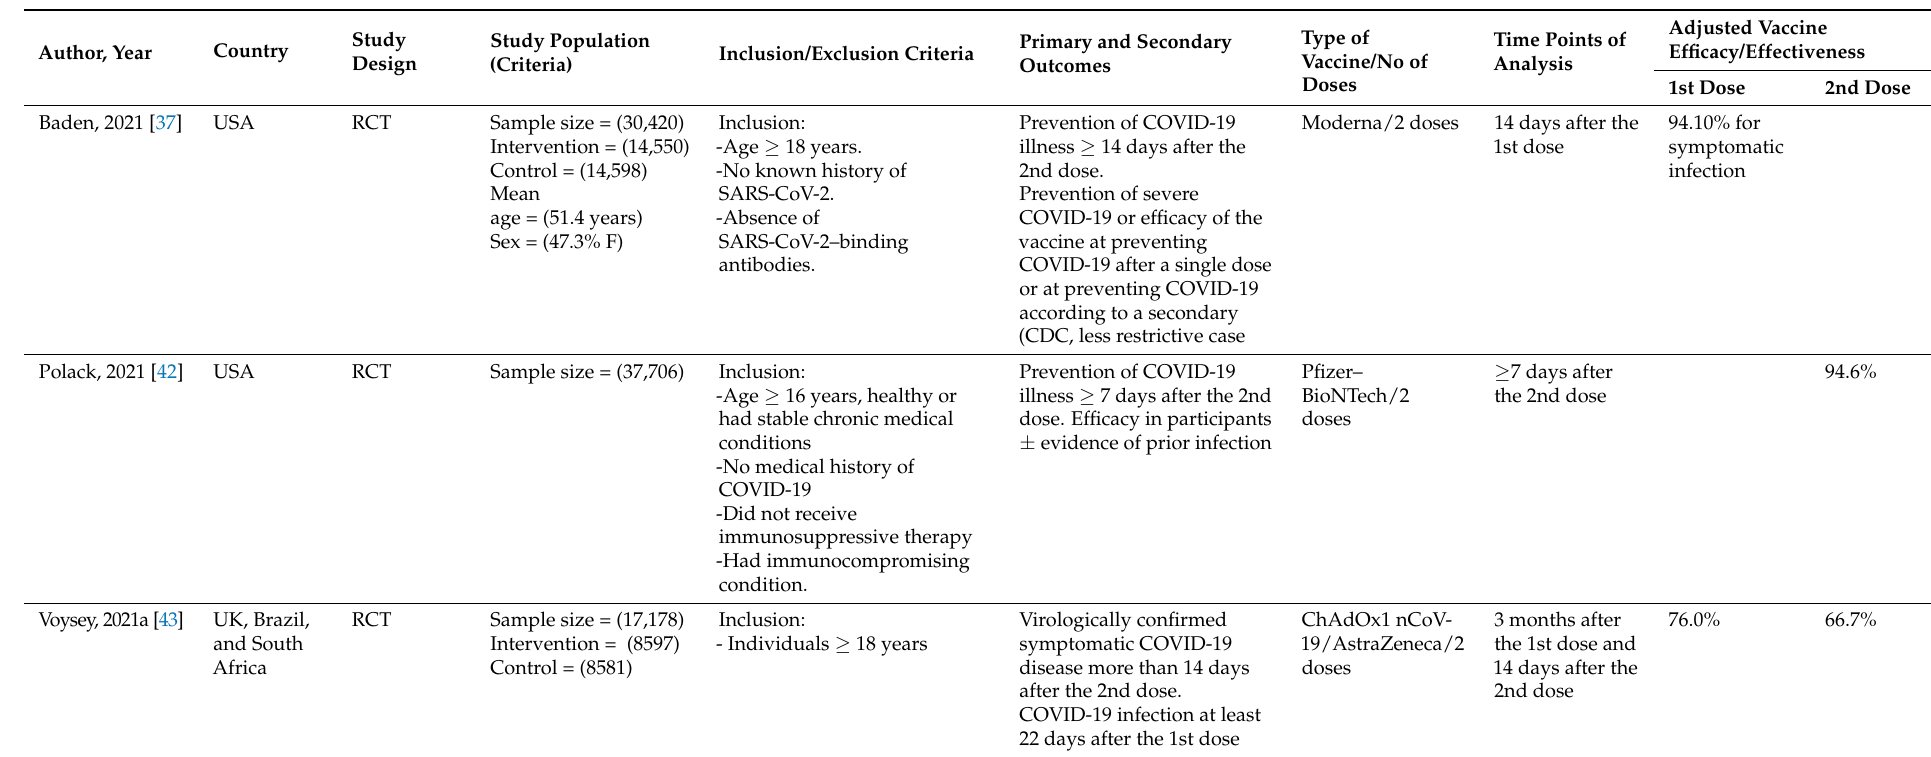
Table 1. Summary of included studies in the quantitative